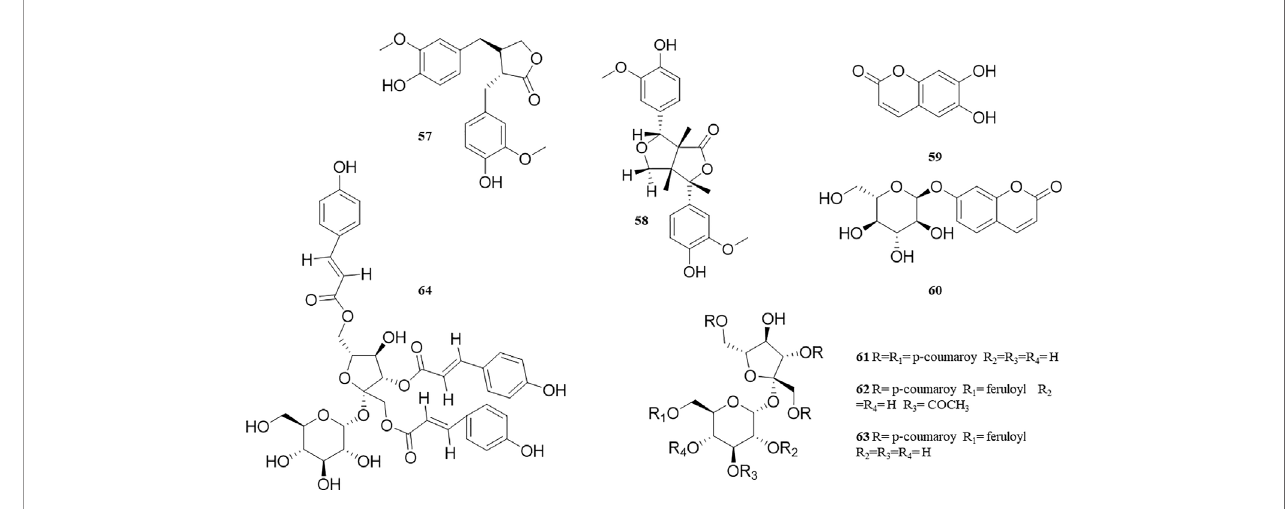
FIGURE 6 | Structure of phenylpropanoids from P. perfoliatum.